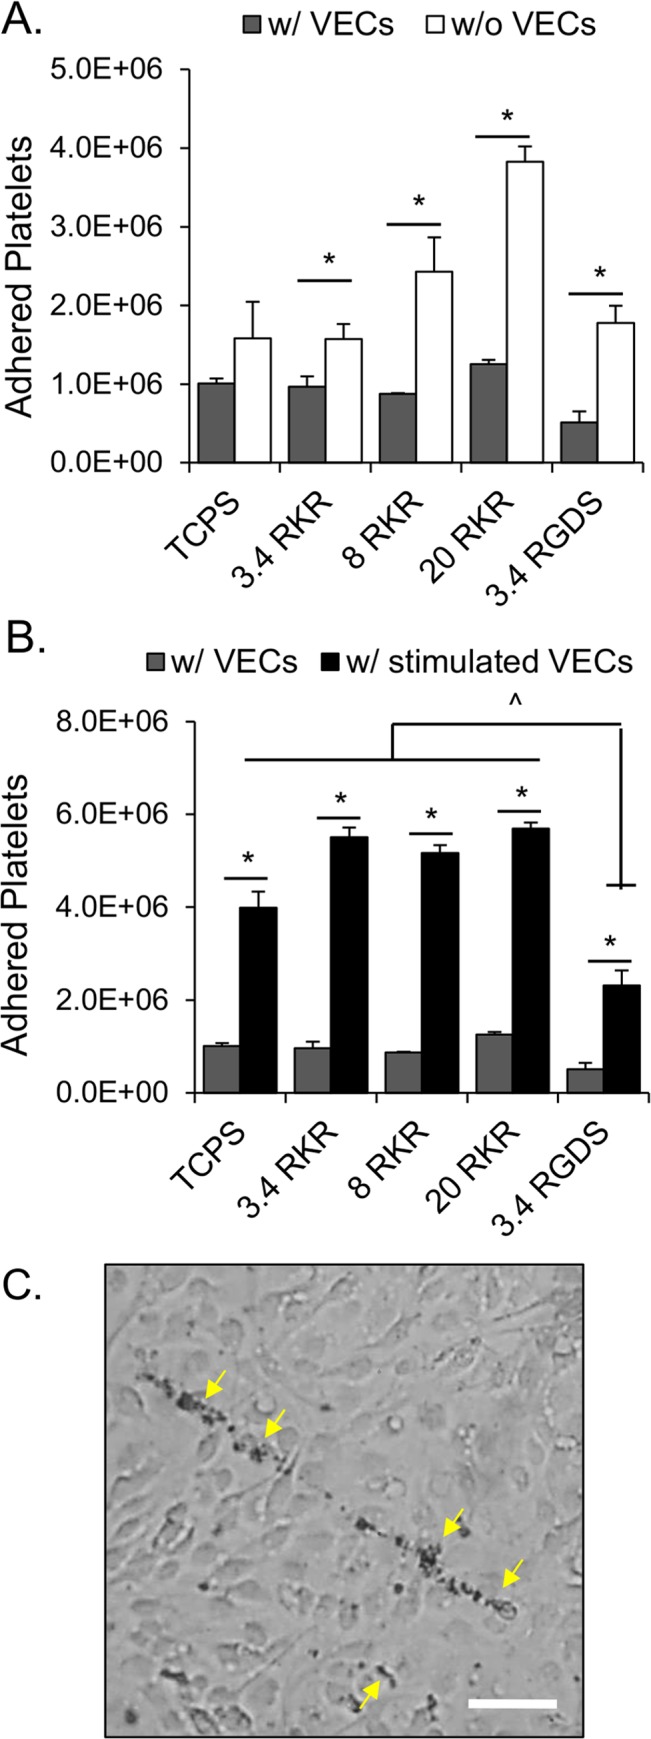
Histamine stimulated VECs on hydrogel based platforms are capable of promoting platelet adhesion.(A) Endothelialized peptide-immobilized hydrogel platforms significantly reduce platelet adhesion. Platelet adhesion on hydrogel scaffolds increases with increasing molecular weight PEGDA hydrogel. Platelet adhesion is significantly reduced on VEC-seeded peptide-coated hydrogels (gray bars) when compared to acellular peptide-coated constructs (white bars). * p <0.05. (B) Total adhered platelets onto stable and stimulated VECs cultured on TCPS and hydrogels with immobilized RKR or RGDS. Histamine stimulated VECs (black bars) of all culture condition promoted significantly more platelet adhesion when compared to the non-simulated VECs cultured on the same condition (gray bars). * p < 0.05. Platelet adhesions were significantly lower for the stimulated VECs on RGDS gels than for all other stimulated conditions. # p < 0.05. (B) Dyed platelets adhered onto anchored ultra-large VWF strings (yellow arrows) on the surface of histamine stimulated VECs cultured on a RKR-3.4 kDa hydrogel. Scale bar = 50 μm.